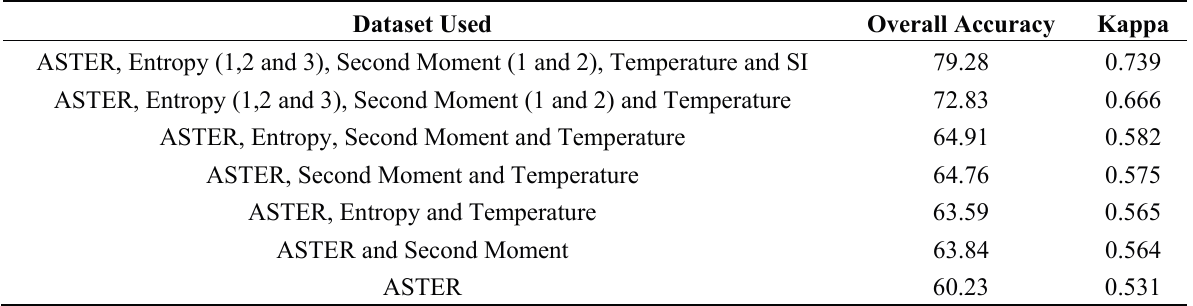
Table 2. Kappa and overall accuracy for different combination datasets using SVM method. Dataset Used Overall Accuracy